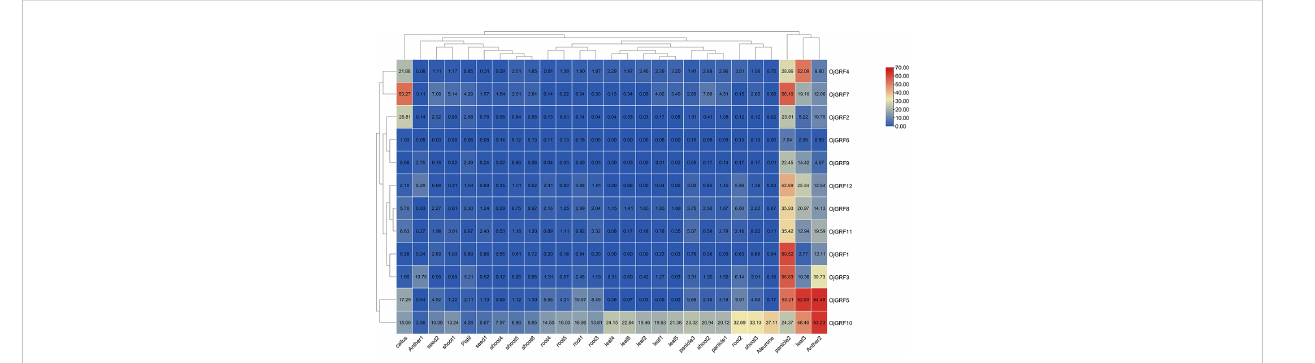
FIGURE 9 Expression pro fi les of the GRFs in the various rice tissues at different developmental stages. The heatmap based on the data of public rice transcriptomic by log 2 FPKM represents the relative expression in 27 tissues. The GRFs are clustered according to hierarchical clustering. The blue and red color indicates the transcripts ’ high and low expression levels,